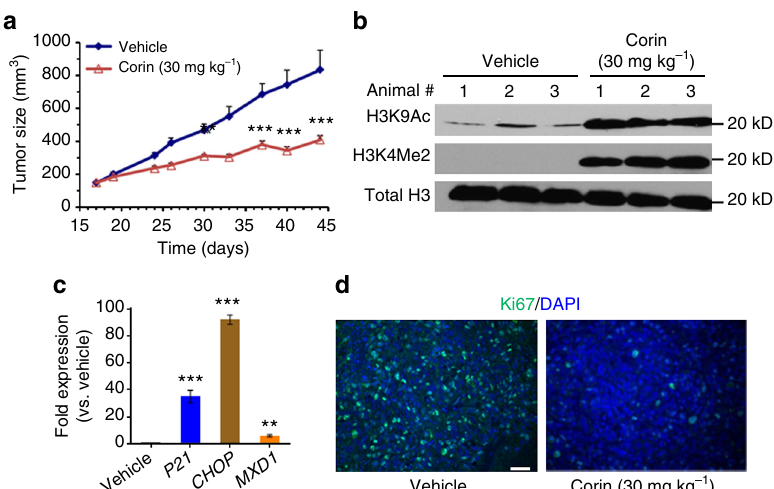
Fig. 6 In vivo analysis of corin in a melanoma xenograft. a Daily IP administration of corin (30 mg kg − 1 ) potently inhibited tumor growth in an SK-MEL-5 melanoma cell mouse xenograft model over the course of a 28-day treatment regimen ( n = 10 mice per condition). b Western blot depicting increases in histone H3K4 methylation and H3K9 acetylation in tumor tissue obtained from the SK-MEL-5 melanoma xenograft. c Gene expression changes induced by corin in mouse xenograft tumor tissue as determined by qRT-PCR. d Corin treatment decreased the expression of Ki67, a biomarker for cell proliferation, in mouse xenograft tumor tissue (scale = 100 µ m). Data (mean ± SEM) are representative of at least two independent experiments (unpaired t test, ** p < 0.01, *** p <